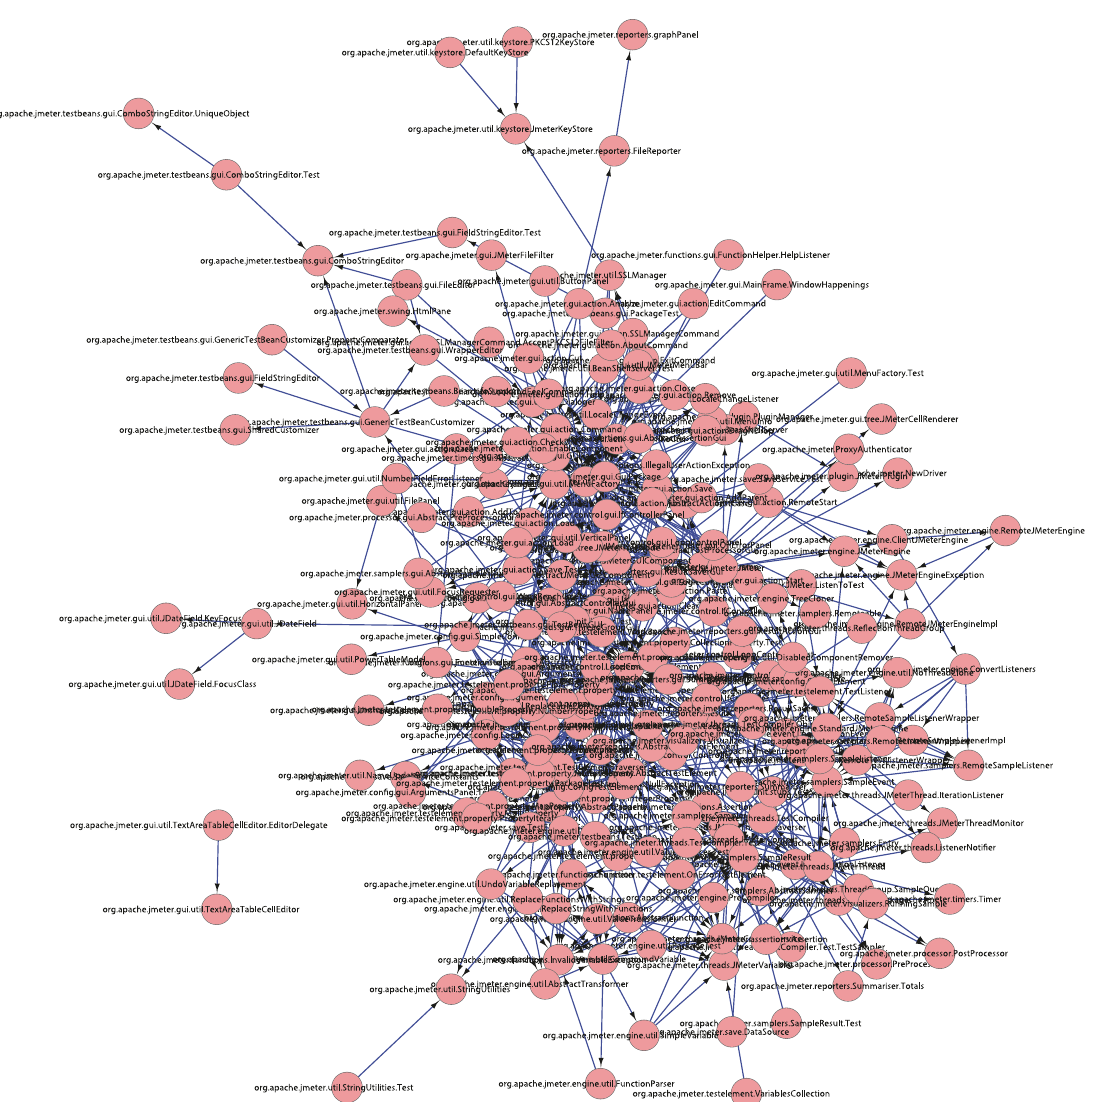
Figure 8: CCN for JMeter. The source file of the figure can be downloaded from https://www.icloud.com/iclouddrive/0sSM4U7- GmxiTLpLfpp0kxcDsg#complexity9414162supp